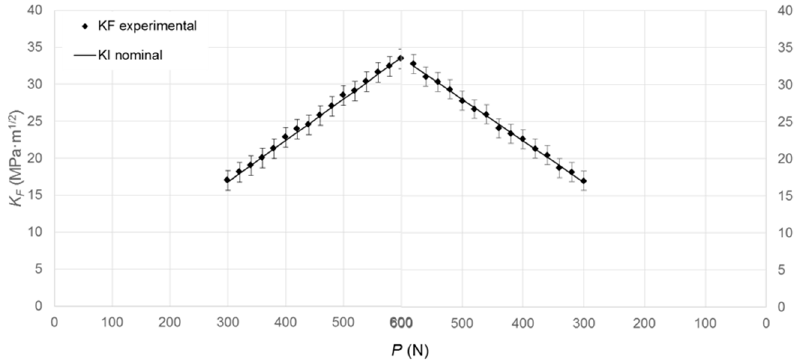
Figure 3. K F along a loading cycle (loading and unloading) calculated through the CJP model for a crack length of 8.63 mm at a stress ratio of 0.5.